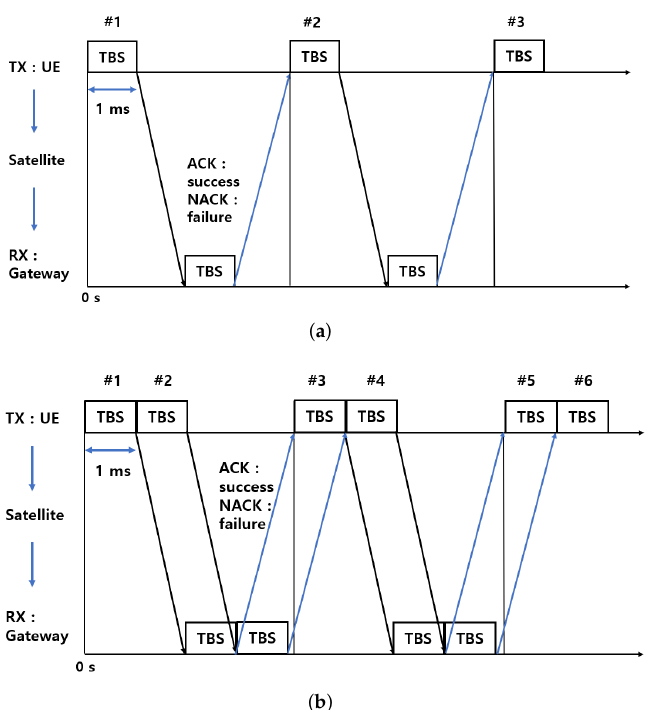
Figure 5. Comparison of the number of HARQ processes. ( a ) One HARQ process, ( b ) Two HARQ